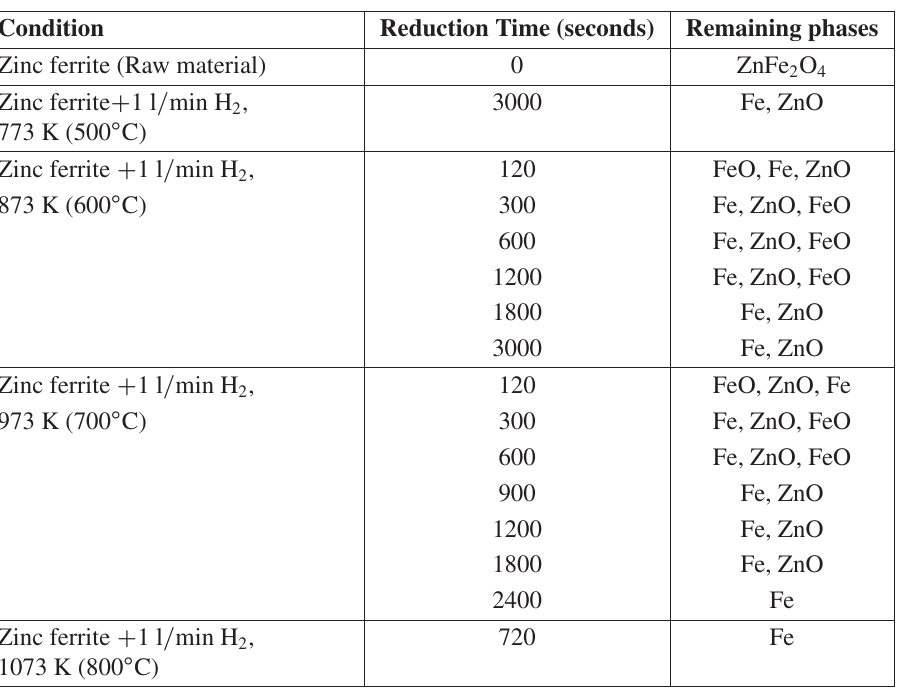
Table 1. Remaining Phases (in order of a main phase respectively) of Zinc Ferrite Reduced by Hydrogen found by XRD Analysis.